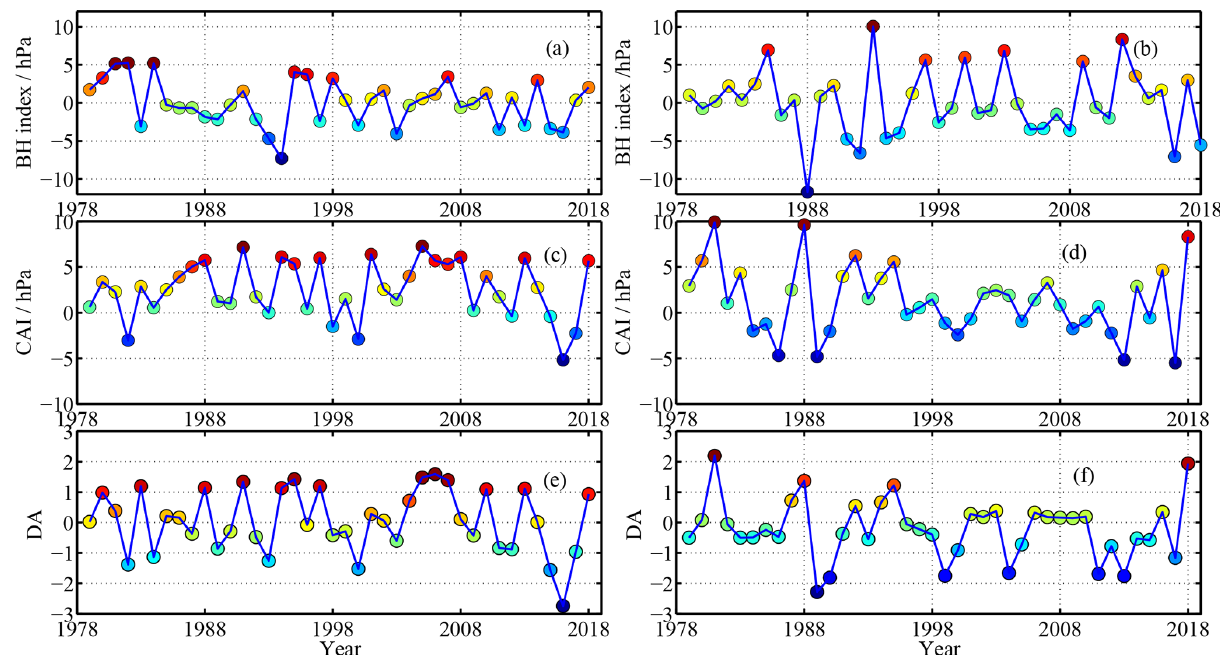
Figure 3. Changes in (a) autumn (SON) and (b) winter (DJF) BH index, (c) autumn and (d) winter CAI, and (e) autumn and (f) winter DA from 1979 to